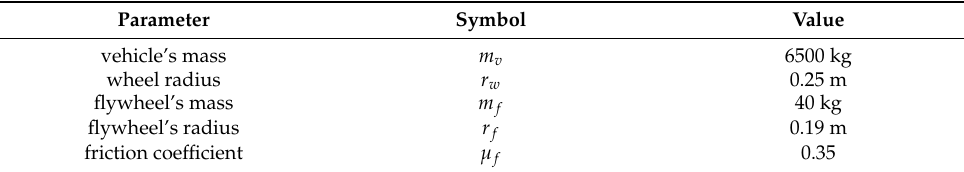
Table 4. The parameters of the vehicle and the